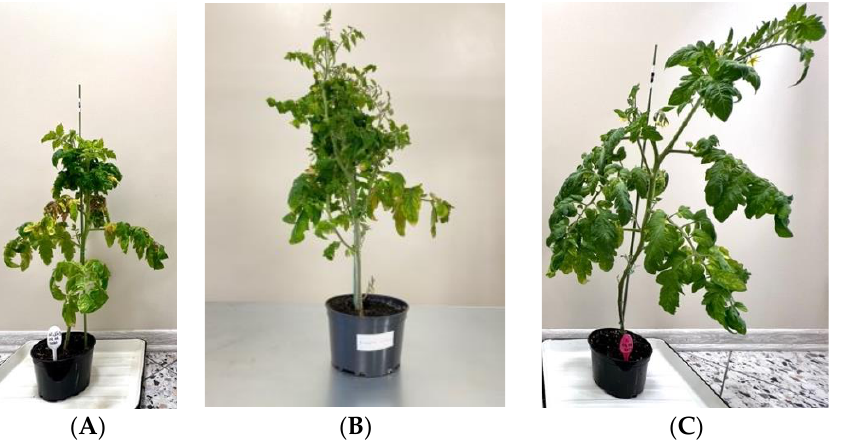
Figure 1. ( A , B ) — symptoms on cv. Rutgers tomatoes infected with the PSTVd strain NicTr-3 at 30 Figure 1. ( A , B )—symptoms on cv. Rutgers tomatoes infected with the PSTVd strain NicTr-3 at days post inoculation (dpi); ( C ) — mock. 30 days post inoculation (dpi); ( C